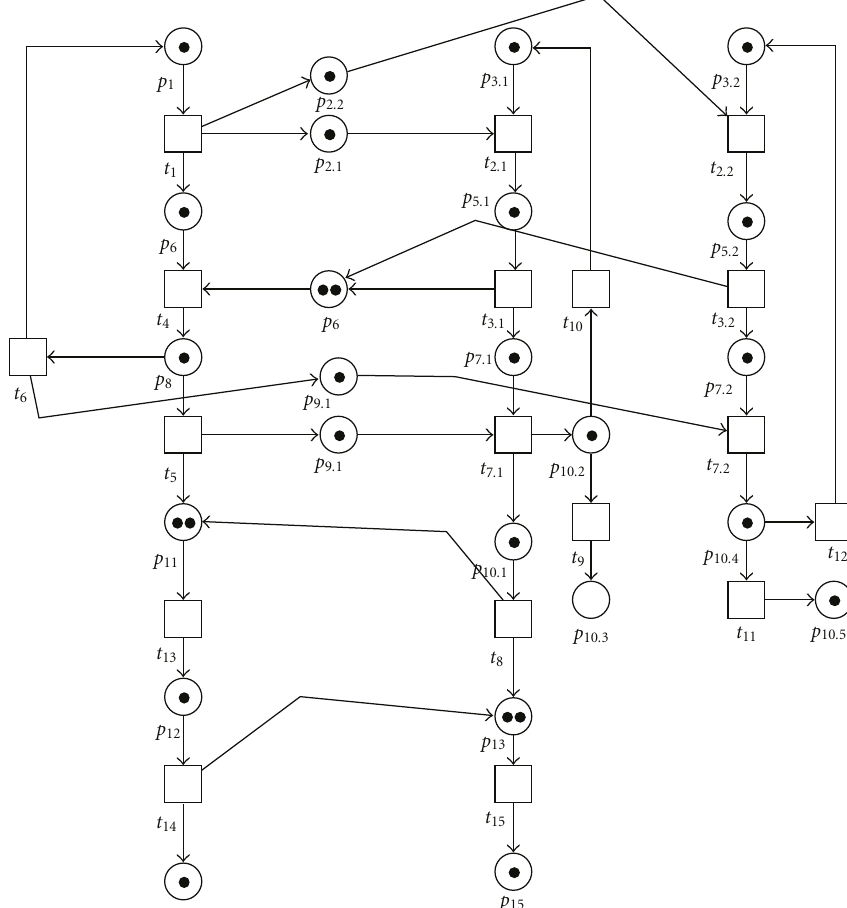
Figure 6: Spectrum sharing process between an SU and two